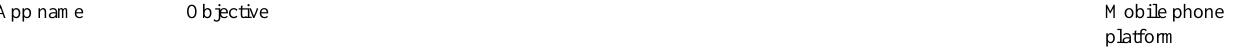
Mobile phone platformObjectiveApp